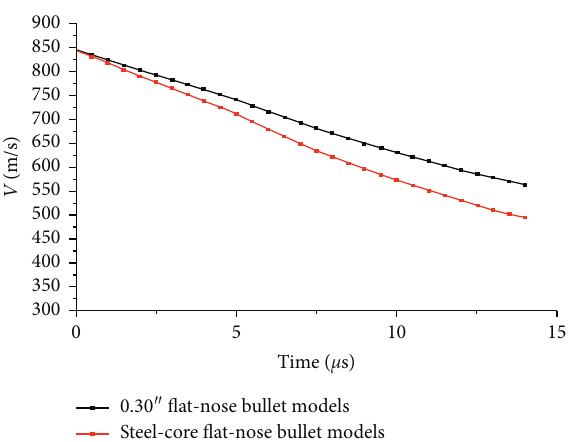
Figure 15: Velocity-time diagram of the bullet (5% 333 FGM + 4mm Al backplate).